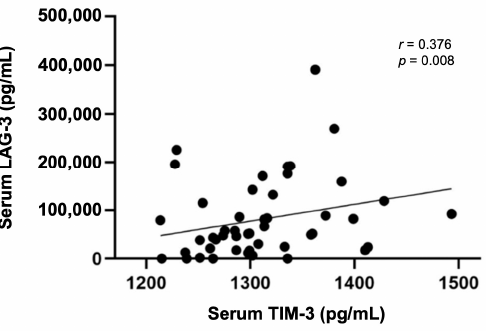
Figure 7. Box plot analysis of serum TIM-3 levels and their association with the TIM-3 expression in stromal and total TILs. ( a ) Serum TIM-3 levels and s TILs (sTILs Low , n = 22; sTILs High , n = 20). ( b ) Serum TIM-3 levels and t TILs (tTILs Low , n = 22; tTILs High , n = 23) (* p < 0.05).